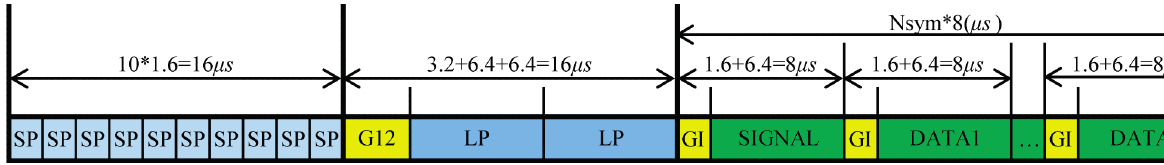
Figure 1. Format of IEEE802.11p PHY